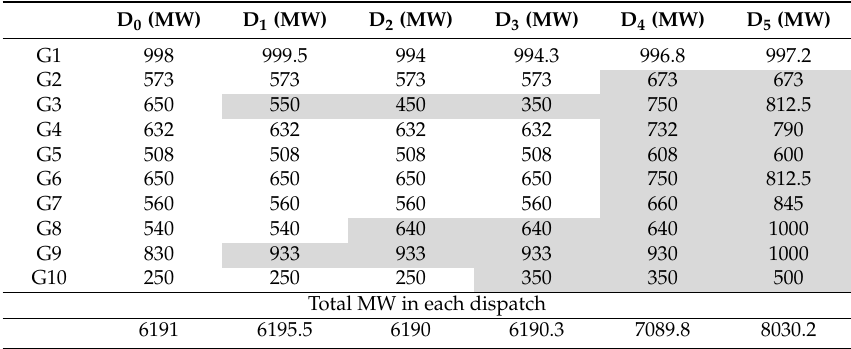
Table 1. IEEE 39-bus system